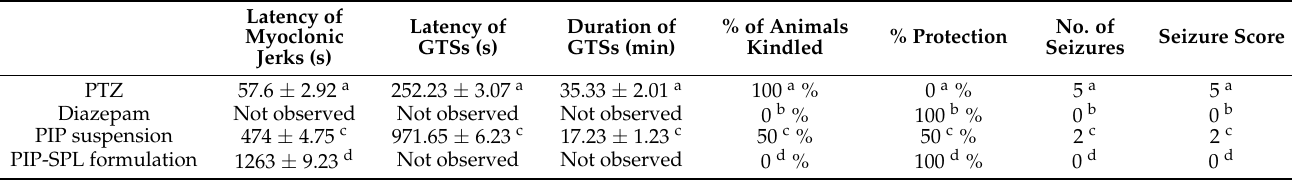
Figure 10. Effect of different treatments on latency of seizures, no. of seizures, and % seizure occurrence (*** indicates that the comparison was made between normal vs. other groups, whereas ### indicates that the comparison was made between control and other groups). Table 5. Effect of different treatments on seizure activity.